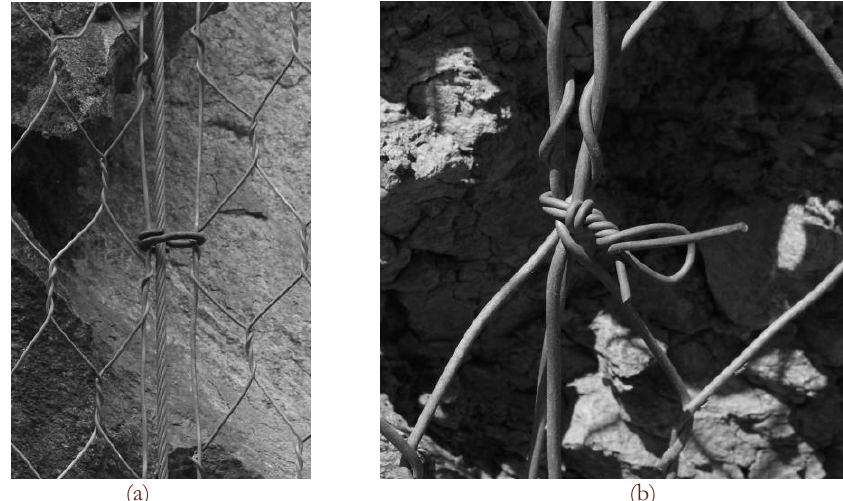
Figure 2: Different connections between the panels: (a) a vertical rope with clips, (b) knots (close view).